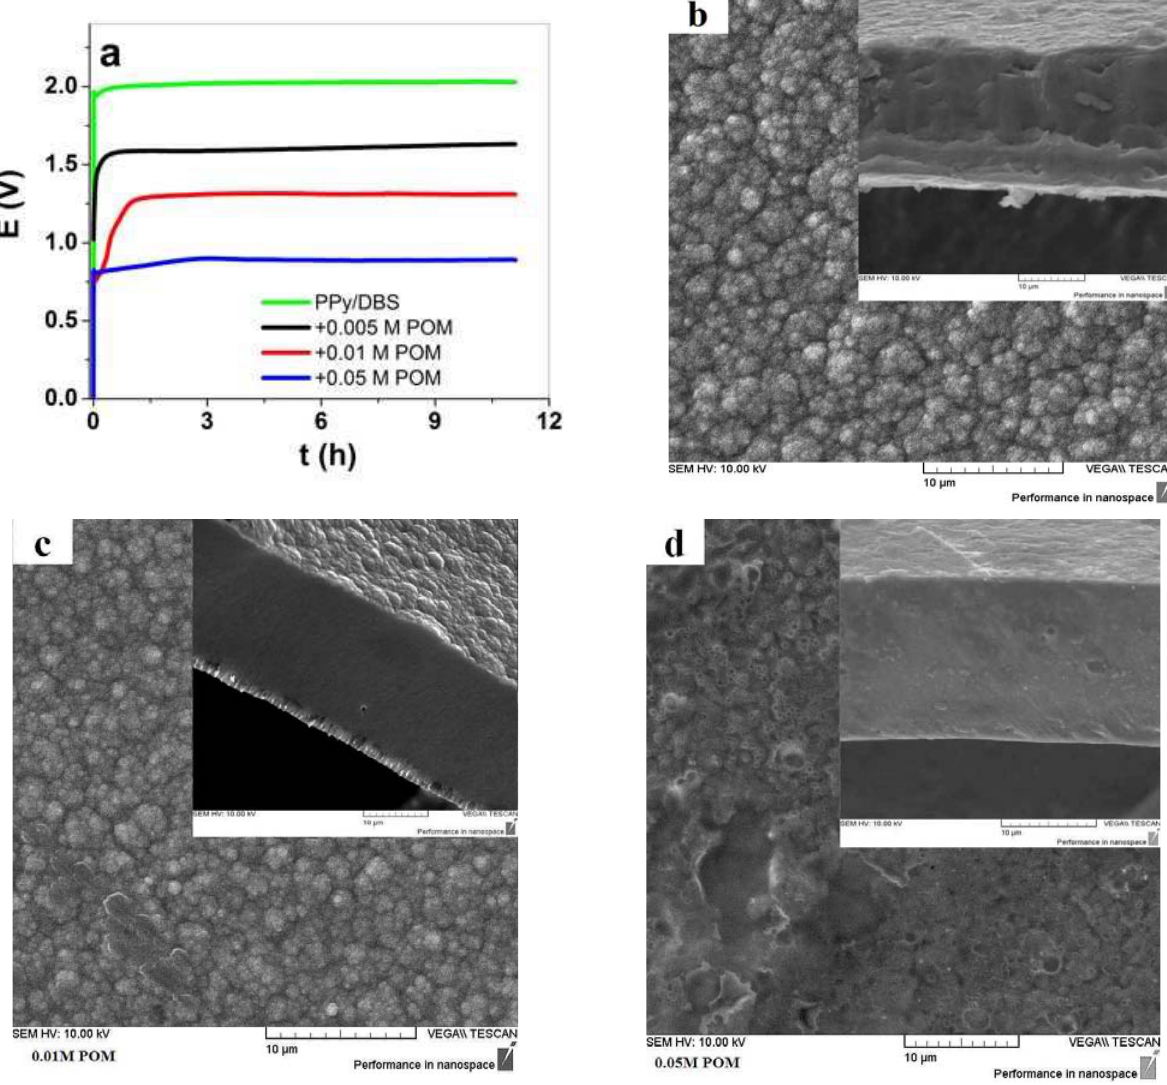
Figure 1. ( a ) Galvanostatic electropolymerization (0.1 mA cm − 2 ) showing potential against time of PPy/DBS (green curve), with additions of 0.005 M PTA (black curve), 0.01 M PTA (red curve), and 0.05 M PTA (blue curve). The SEM surface images, with insets showing cross-section images (scale bar 10 µ m), of PPy/DBS-PT films with different concentrations of PTA are presented in ( b ) with 0.005 M, ( c ) with 0.01 M, and ( d ) with 0.05 M. Table 1. Electronic conductivity and elastic modulus of PPy/DBS-PT films before and after actuation.